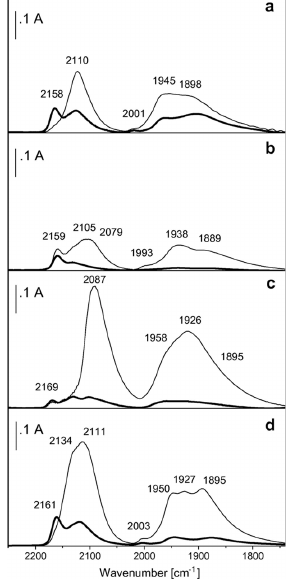
Figure 19. FTIR spectra of CO adsorbed at 180 K on Pd ( a ), 1Au2Pd ( b ), 1Pd2Au ( c ), and PdAu ( d ) after pre-treatment in H 2 at room temperature (fine curves) and after pre-treatment in H 2 and O 2 at r.t. (bold curves). Reprinted from J. Catal., 268, F. Menegazzo, M. Signoretto, M. Manzoli, F. Boccuzzi, G. Cruciani, F. Pinna, G. Strukul, Influence of the preparation method on the morphological and